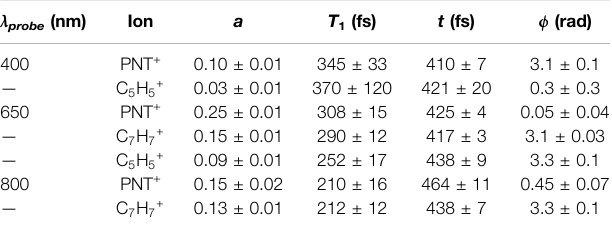
TABLE1| Curve fi ttingcoef fi cientsforcoherentdynamicsofionsignals:oscillation amplitude ( a ), coherent lifetime ( T 1 ), oscillation period ( t ), and phase ( ϕ